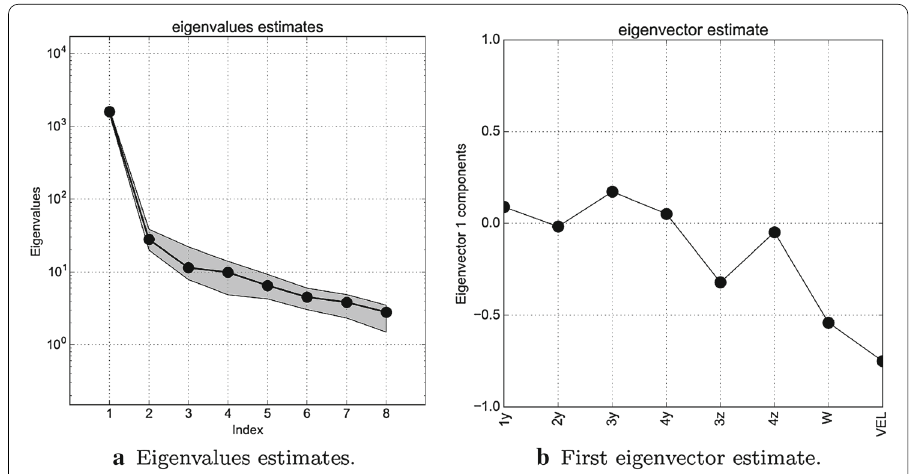
Fig. 10 Plot a shows the eigenvalue estimates in block circles with the bootstrap intervals (grey region). The order-of-magnitude gaps between the eigenvalues suggest confidence in the dominance of the active subspace. Plot b shows the components of the eigenvector correspondent to the greatest eigenvalue